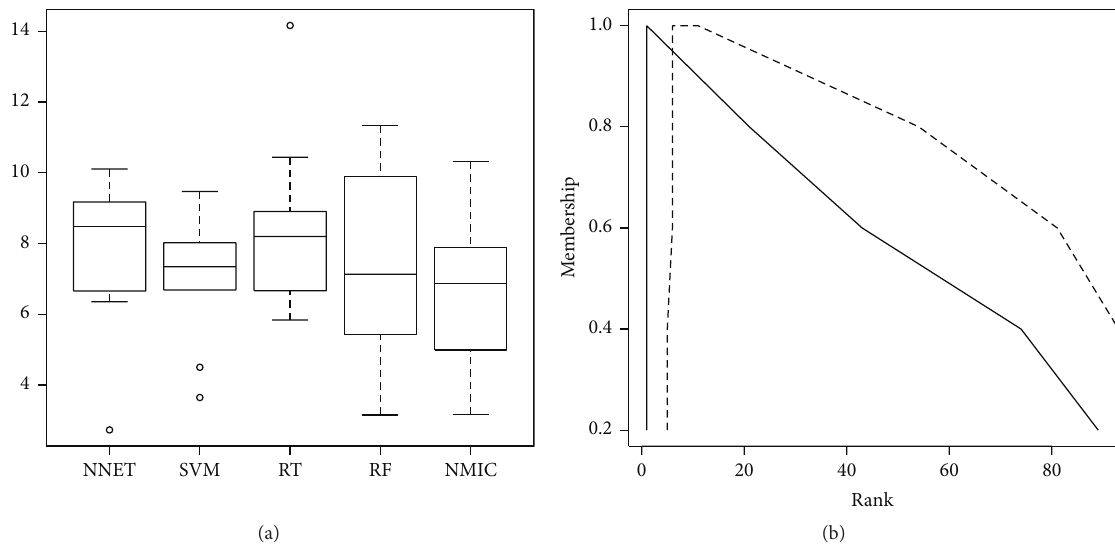
Figure 4: (a) Boxplot showing the statistical differences between the test error of the combination of Neural Networks (NN), Support Vector Machines (SVM), Regression Trees (RT), Random Forests (RF), and NMIC with the feature set computed as described in this paper. NMIC exploits the imprecision in the information better than the alternatives. (b) Membership functions of the ranks of the first (solid) and 10th (dashed) features, that is, COCOMO SLOC and McCabe complexity.